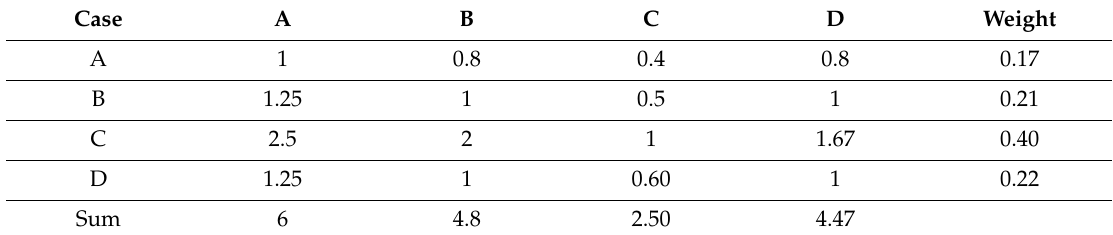
Table A5. Pairwise comparison of alternatives based on Availability.